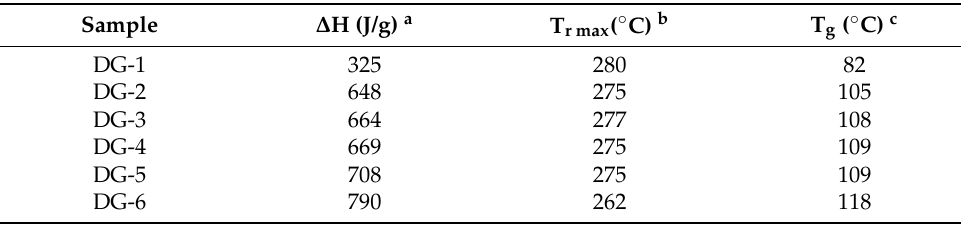
Figure 6. ( A ) DSC thermograms of the first heating scan (heating rate 5 °C/min) and ( B ) second heating scan (heating rate 20 °C/min) for the systems DG-1 (a), DG-2 (b), DG-3 (c), DG-4 (d), DG-5 (e), and DG-6 (f). Table 4. Relevant DSC data of DEGBA/guanine (DG)